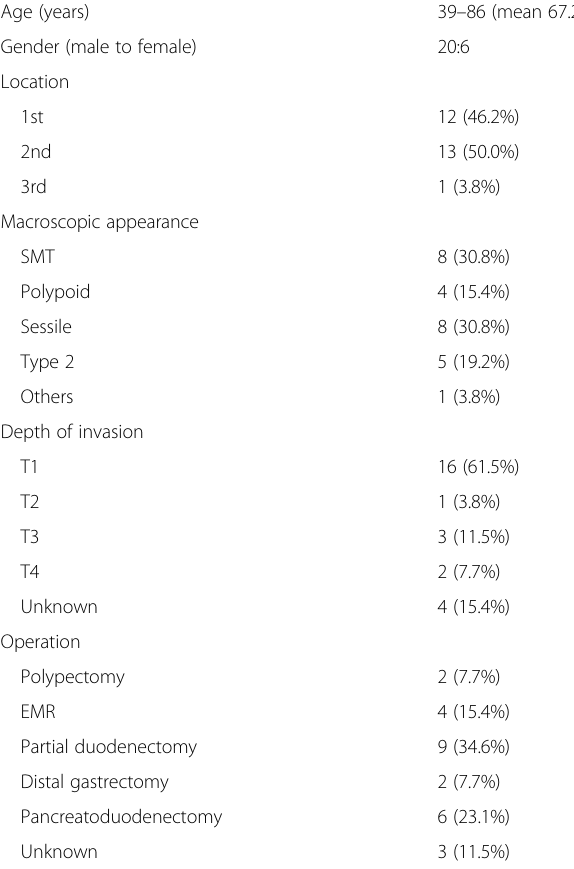
Table 1 Review of duodenal carcinoma arising from the Brunner ’ s